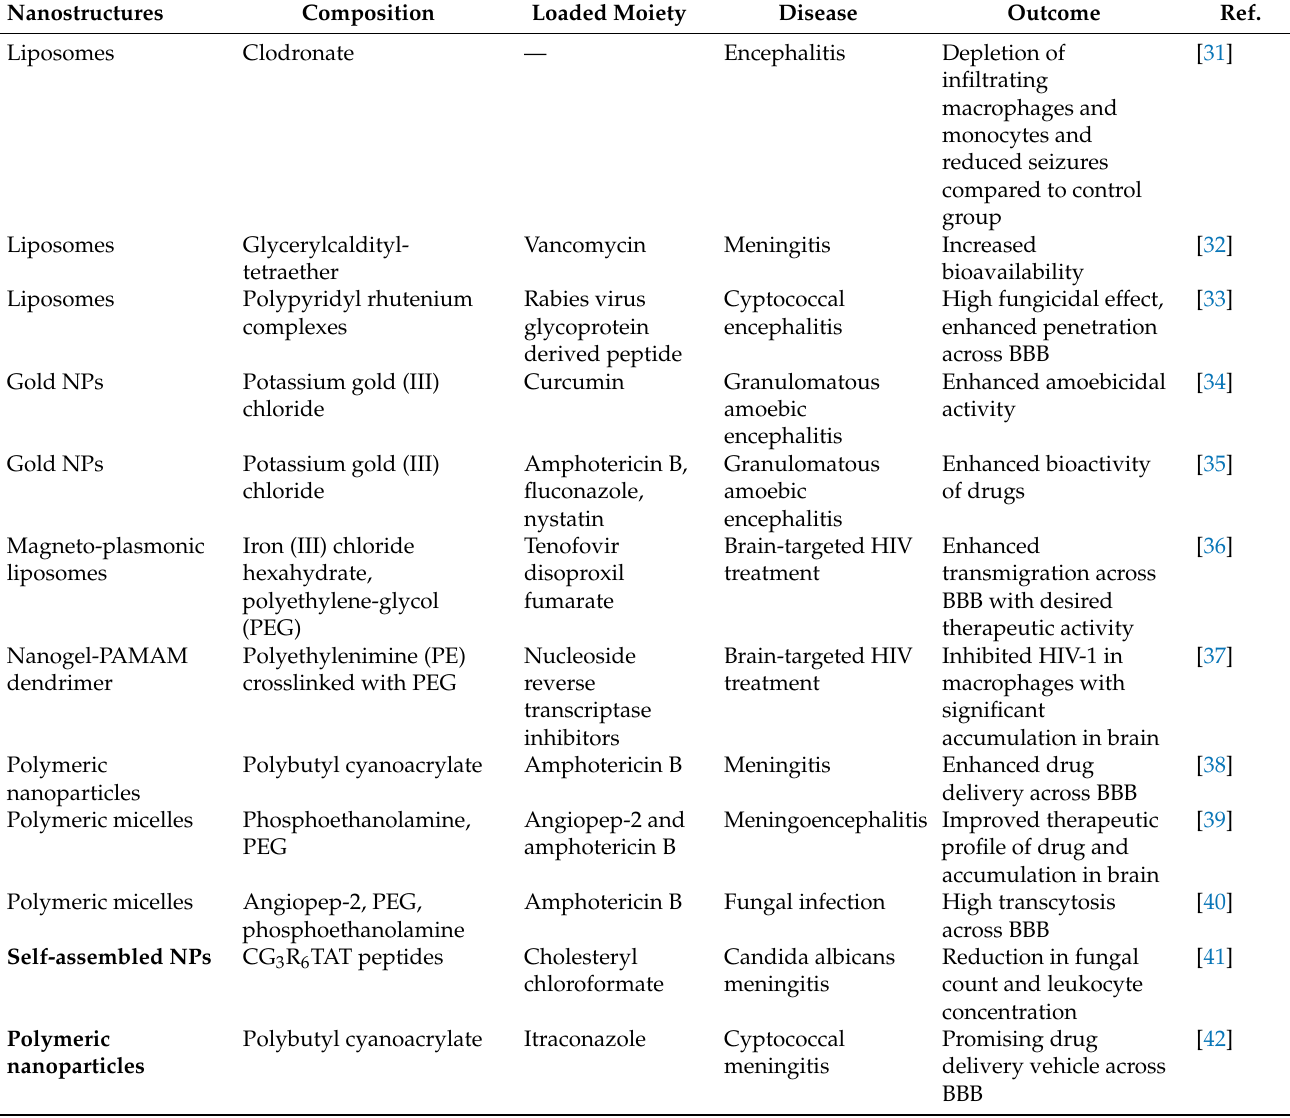
Table 1. Different nanoparticles for treatment of brain infections and